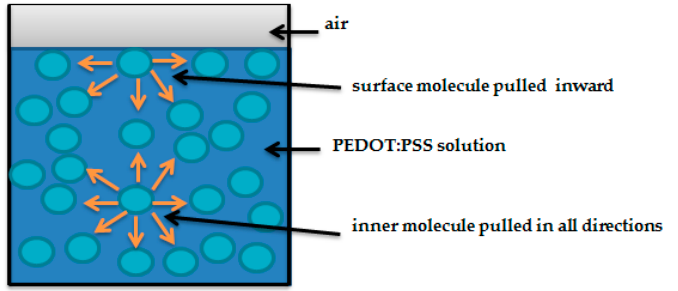
Table 1. Measured physical properties of PEDOT:PSS solutions.